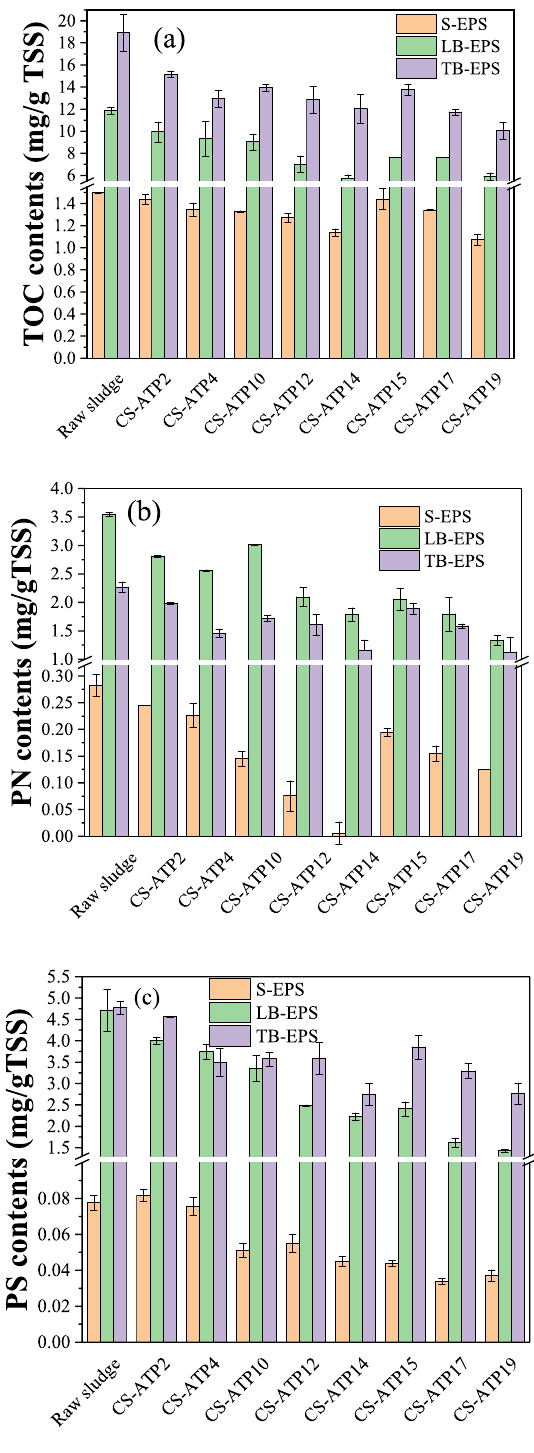
Figure 8. The contents of different EPS components in sludge conditioned by St-CTA in conjunction with ATP using different doses: ( a ) TOC, ( b ) protein (PN) and ( c ) polysaccharides